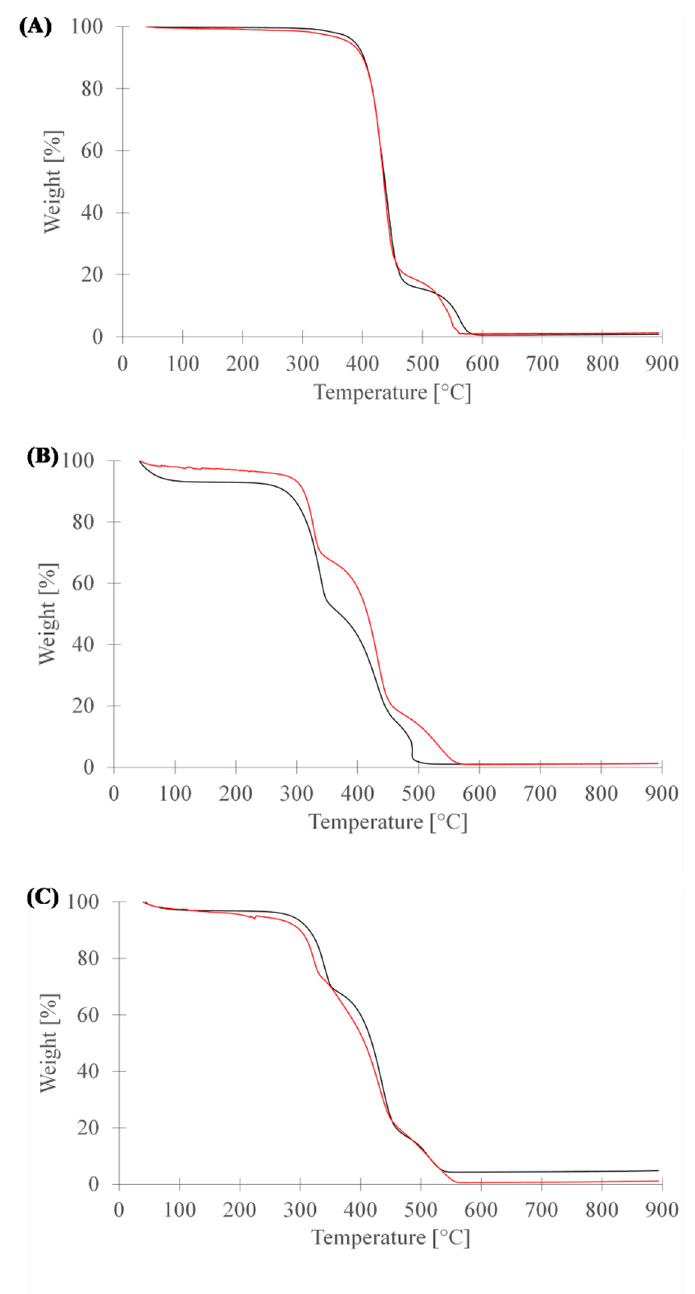
Figure 5. TGA results for neat and PANI-coated PET fabrics ( A ), viscose fabrics ( B ) and 50:50 PET:viscose fabrics ( C ). Black line – neat fabrics and red line—PANI-coated fabrics. Thermal decomposition of the unmodified viscose fabric began at around 230 ◦ 330 C, while for PANI-coated fabrics, it ended at 325 destruction of the crystalline structures of the viscose [94] and its amorphous region degradation into D-glucopyranose monomers [91,93,94]. The rest of the coated fabric degradation ended at 548